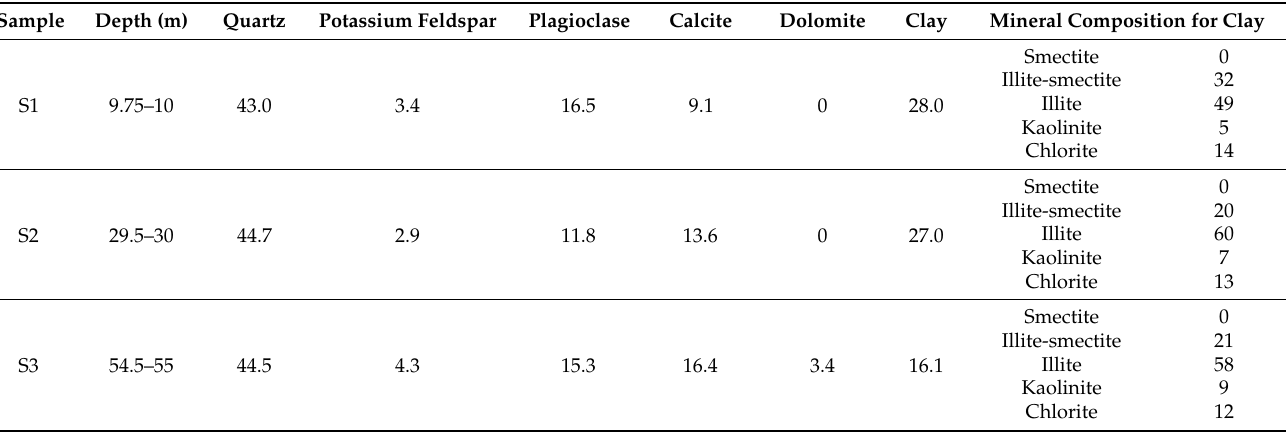
Table 1. The mineral composition for loess (%), modified from [18] under the Creative Commons Attribution (CC BY) license.